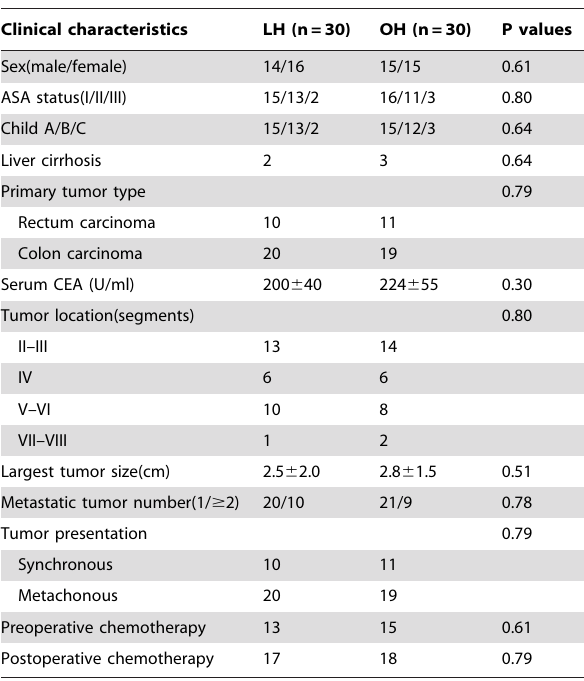
Table 1. Clinicopathologic characteristics of all included patients.